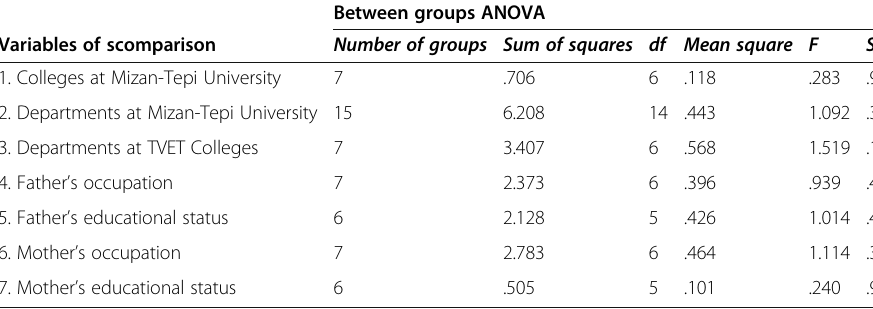
Between groups ANOVA